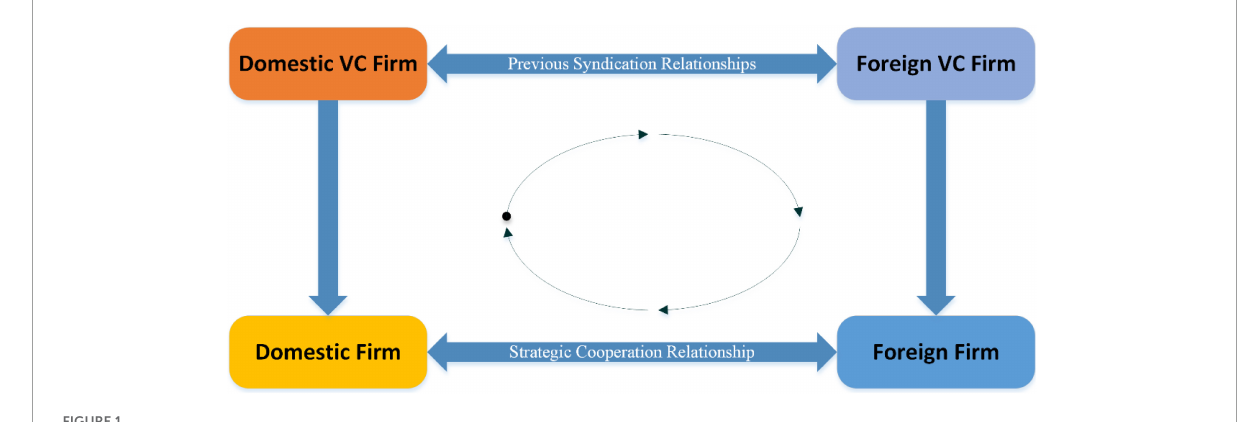
FIGURE1 Structure of the cross-border quadratic relationship